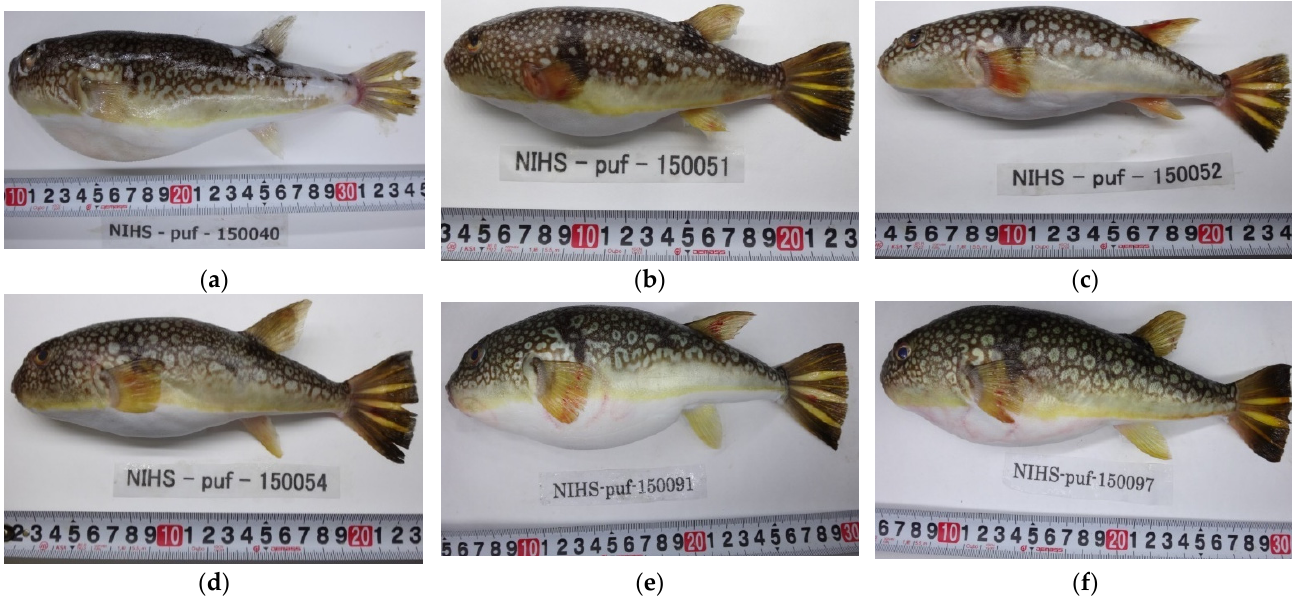
Figure 3. The toxic specimens of the puffer fish, Takifugu flavipterus , captured from Seto Inland Sea, Japan. ( a ) NIHS-puf- 150040: without freeze–thaw, but not in good condition. ( b ) NIHS-puf-150051, ( c ) 150052, and ( d ) 150054: freeze–thawed before cutting into each tissue (flesh and skin). ( e ) NIHS-puf-150091 and ( f ) 150097: not freeze–thawed.